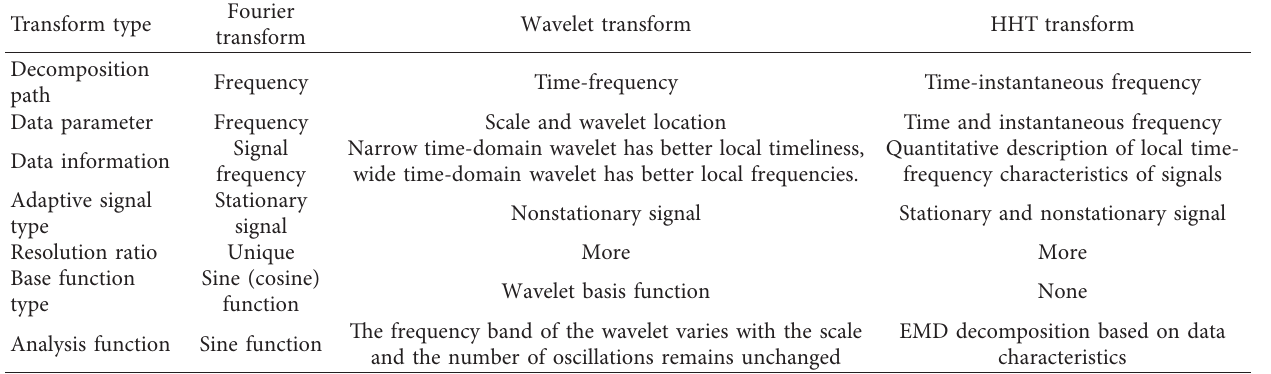
Table 1: Basic properties of different